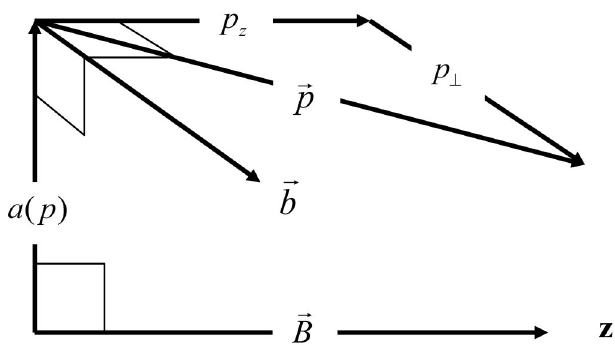
FIG. 5. Diagram of important relationships. The z axis coin- cides with the solenoid axis. At the periodic orbit, the transverse helical dipole field b is orthogonal to B and the radius vector a . The pitch angle of the helix is the arctan ( (cid:25) (cid:11) p ? =p